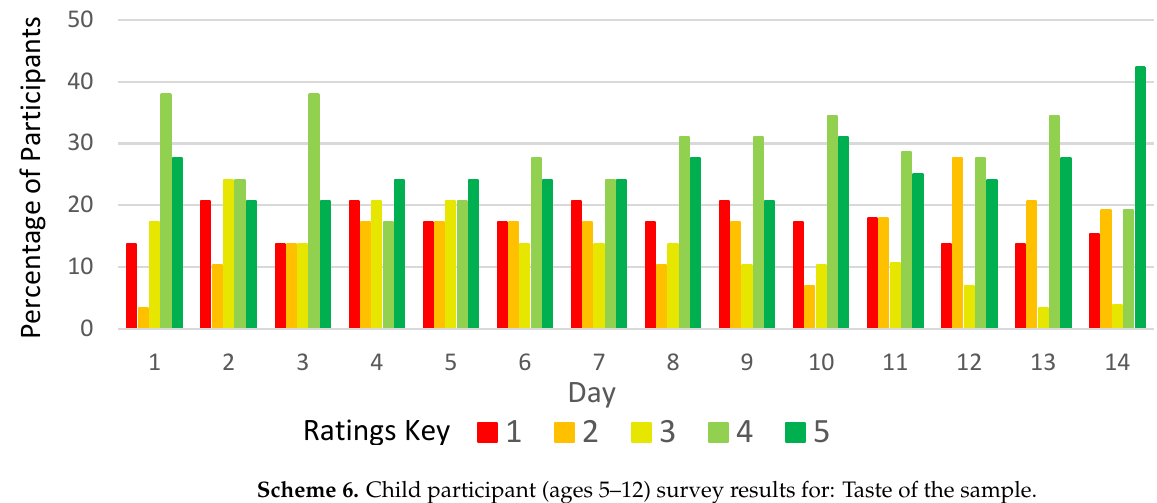
Scheme 6. Child participant (ages 5–12) survey results for: Taste of the sample .